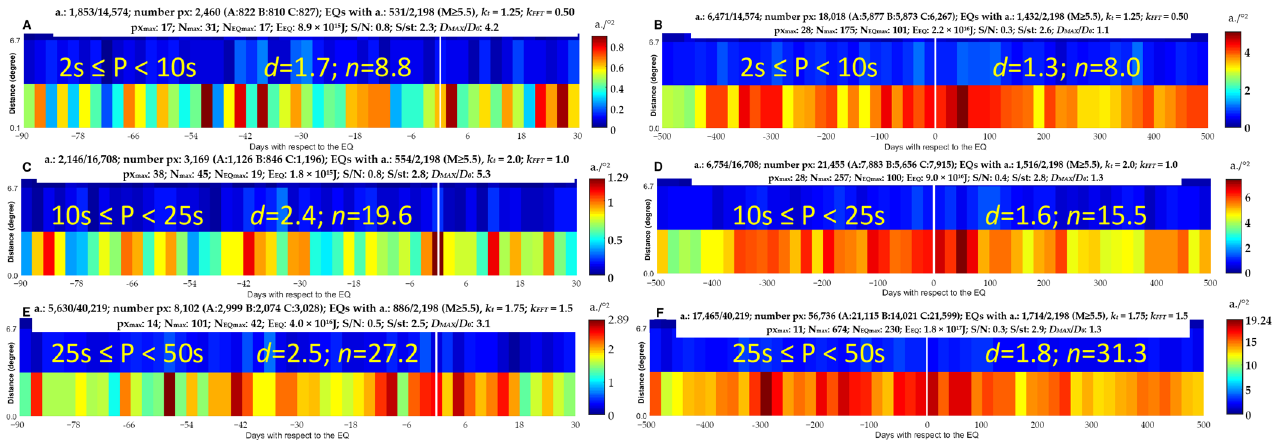
Figure 4. 8-year Swarm Ne data WSC analyses separated for frequency content in the anomalies correlated with M5.5+ earthquakes for 120 days (left) and 1000 days (right) around the EQ occurrence, in particular: ( A ) signal period from 2 s to 10 s and analysis from -90 days to +30 days with respect to the earthquake, ( B ) signal period from 2 s to 10 s and analysis from -500 days to +500 days with respect to the earthquake, ( C ) signal period from 10 s to 25 s and analysis from -90 days to +30 days with respect to the earthquake, ( D ) signal period from 10 s to 25 s and analysis from -500 days to +500 days with respect to the earthquake, ( E ) signal period from 25 s to 50 s and analysis from -90 days to +30 days with respect to the earthquake, and ( F ) signal period from 25 s to 50 s and analysis from -500 days to +500 days with respect to the earthquake. The color bar represents the density of the anomalies in terms of the number of anomalies per square degree.